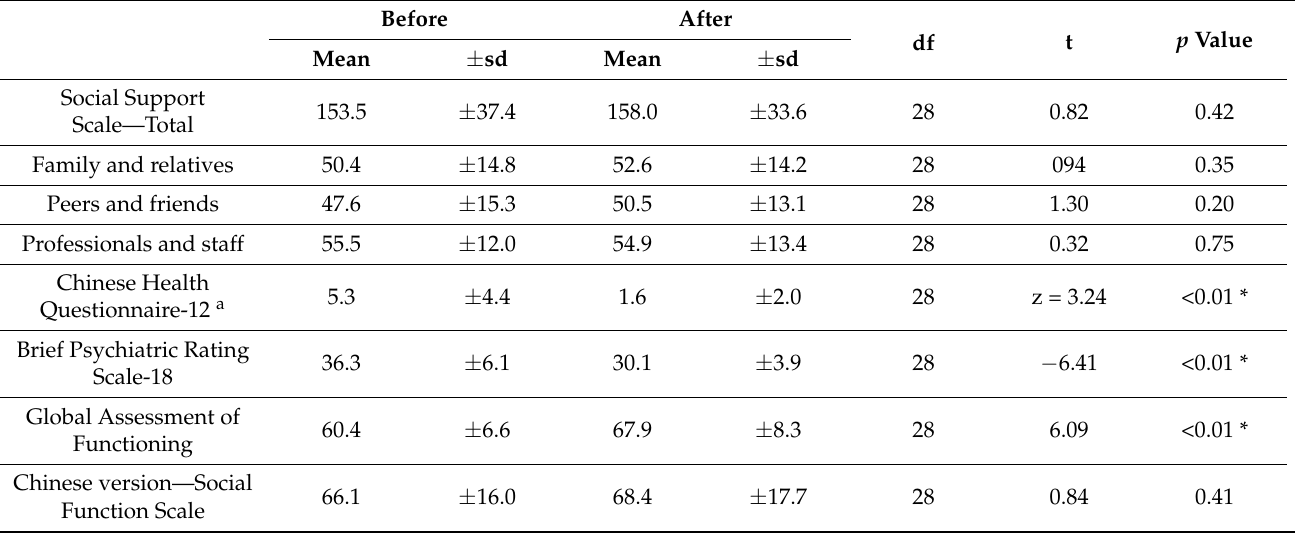
Table 6. The measured outcomes among service users before and after the internship services ( n =